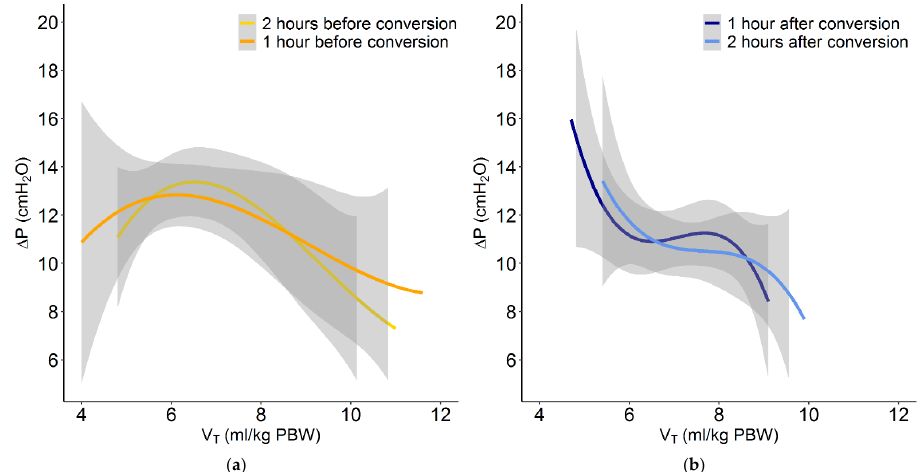
Figure 3. Plot of the relation between V T and Δ P with conventional ventilation at ( a ) 2 and 1 h before conversion to INTELLiVENT-ASV, and at ( b ) 1 and 2 h after conversion.